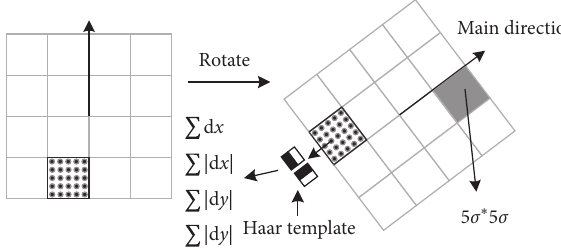
Figure 4: Region feature generation.